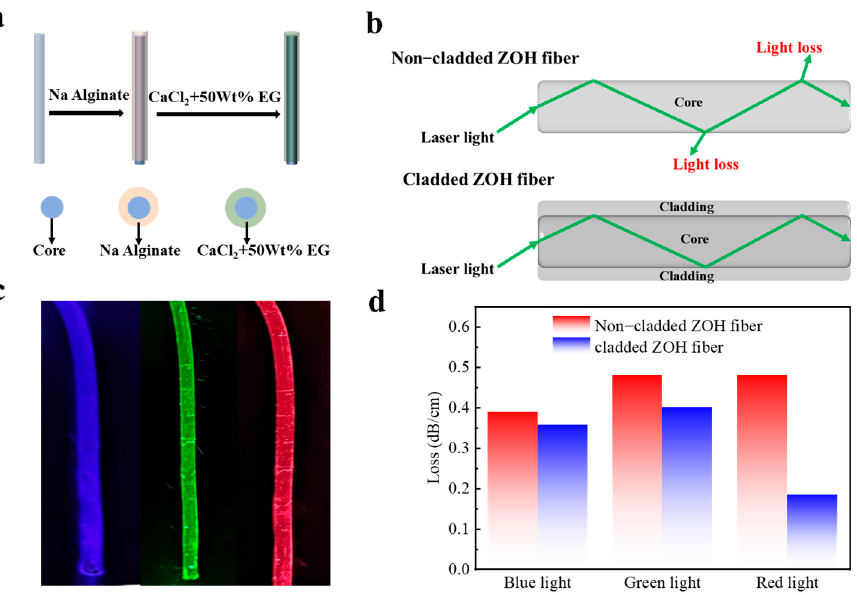
Figure 5. ( a ) Scheme of the fabrication of the core − coated ZOH optical fiber. ( b ) Schematic of the light transmission difference between the non-coated and the coated ZOH fiber. ( c ) Photos of lasers of different wavelengths passing through the coated ZOH fiber. ( d ) Optical transmission loss of lasers with different wavelengths passing through the non-coated and the coated ZOH